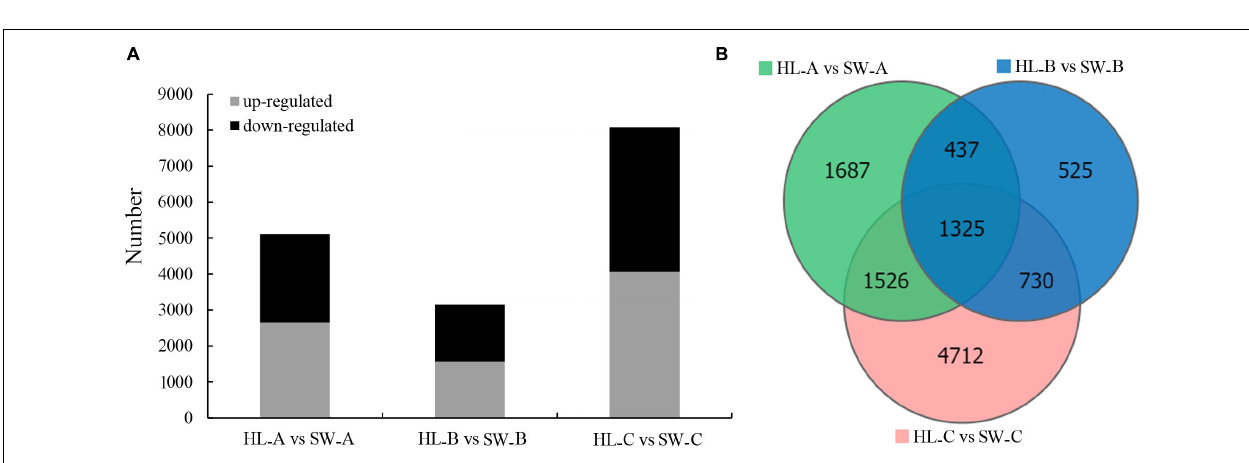
FIGURE 4 | Differential gene expression in chestnut buds in the presence of the GWDK in resistant/susceptible cultivars. (A) The number of upregulated and downregulated DEGs